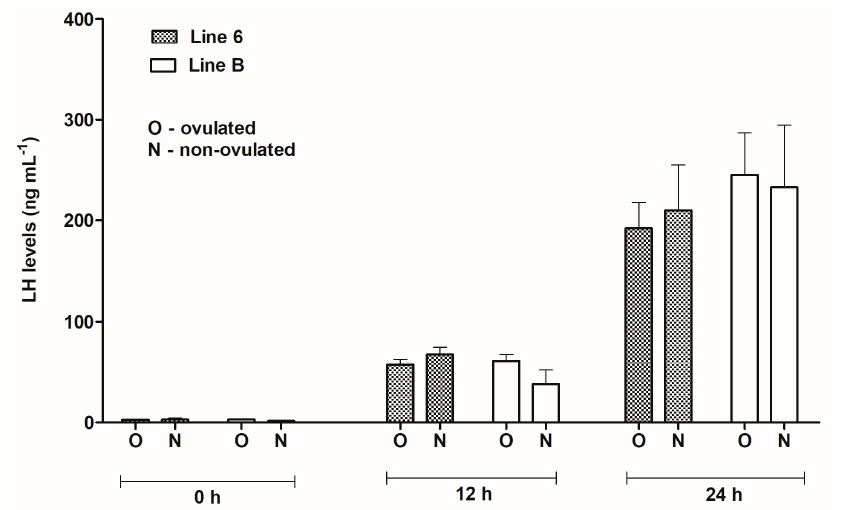
Figure 2. Plasma LH levels in blood samples taken from ovulated and non-ovulated females from Polish line 6 and Lithuanian line B before the first injection of Ovopel (0 h) and 12 and 24 h post- injection (12 and 24 h).